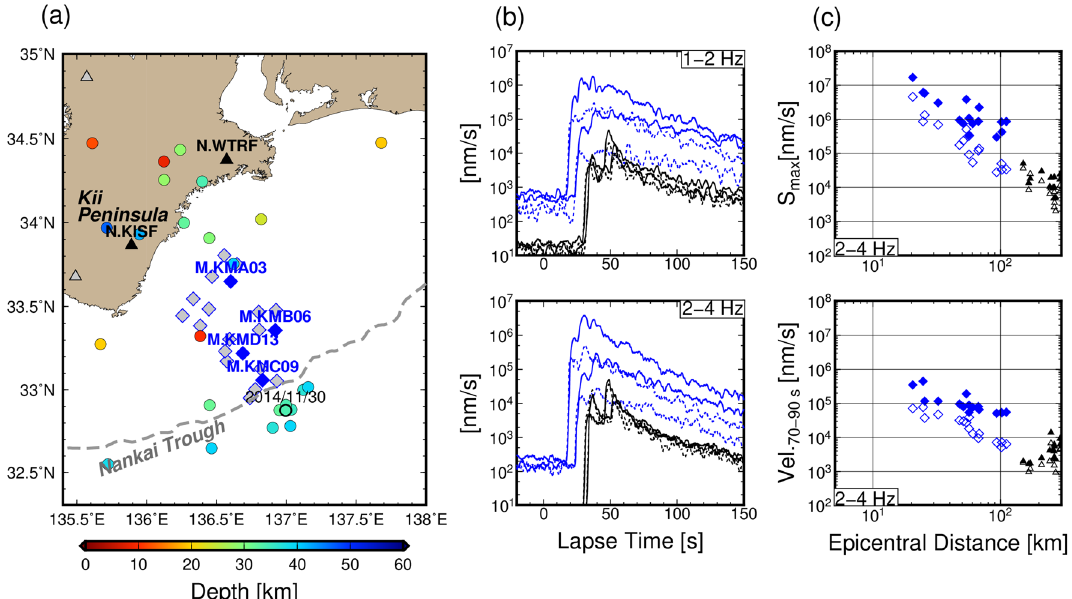
Fig. 1 Map and examples of observed seismogram envelopes around the Nankai Trough. The colored circles in a represent local earthquakes used in this study, and the triangles and diamonds are locations of F-net and DONET stations, respectively (Aoi et al. 2020). Filled triangles and diamonds are stations used in b . The solid and dotted lines in b are horizontal and vertical envelopes. The envelopes at DONET and F-net stations are represented by blue and black lines, respectively. c S max and coda amplitudes as a function of epicentral distance. The filled blue and open diamonds are horizontal and vertical amplitudes at DONET stations, respectively. The filled and open triangles are those at F-net